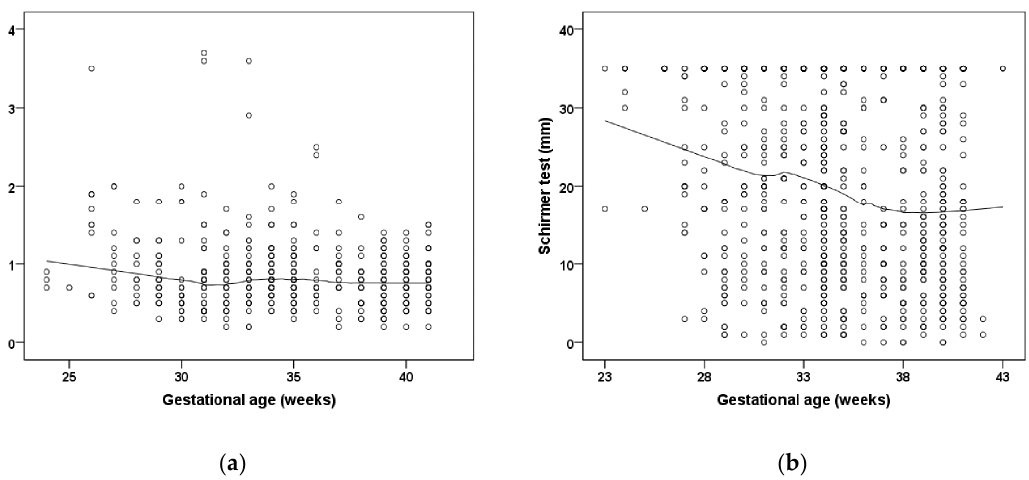
Table 3. Lid parameters of the study groups.